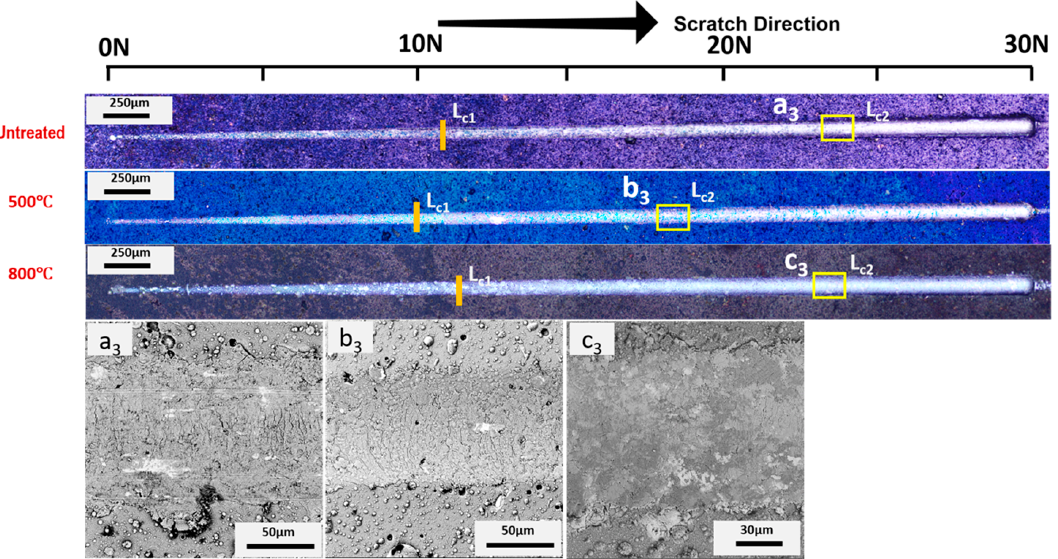
Figure 7. Adhesion optical profile of failure after microscratch tests of the AlTiSiN/steel sample. First ( L c1 ) and second ( L c2 ) critical loads are indicated. SEM magnification of selected areas (a 3 , b 3 and c 3 ) are also presented